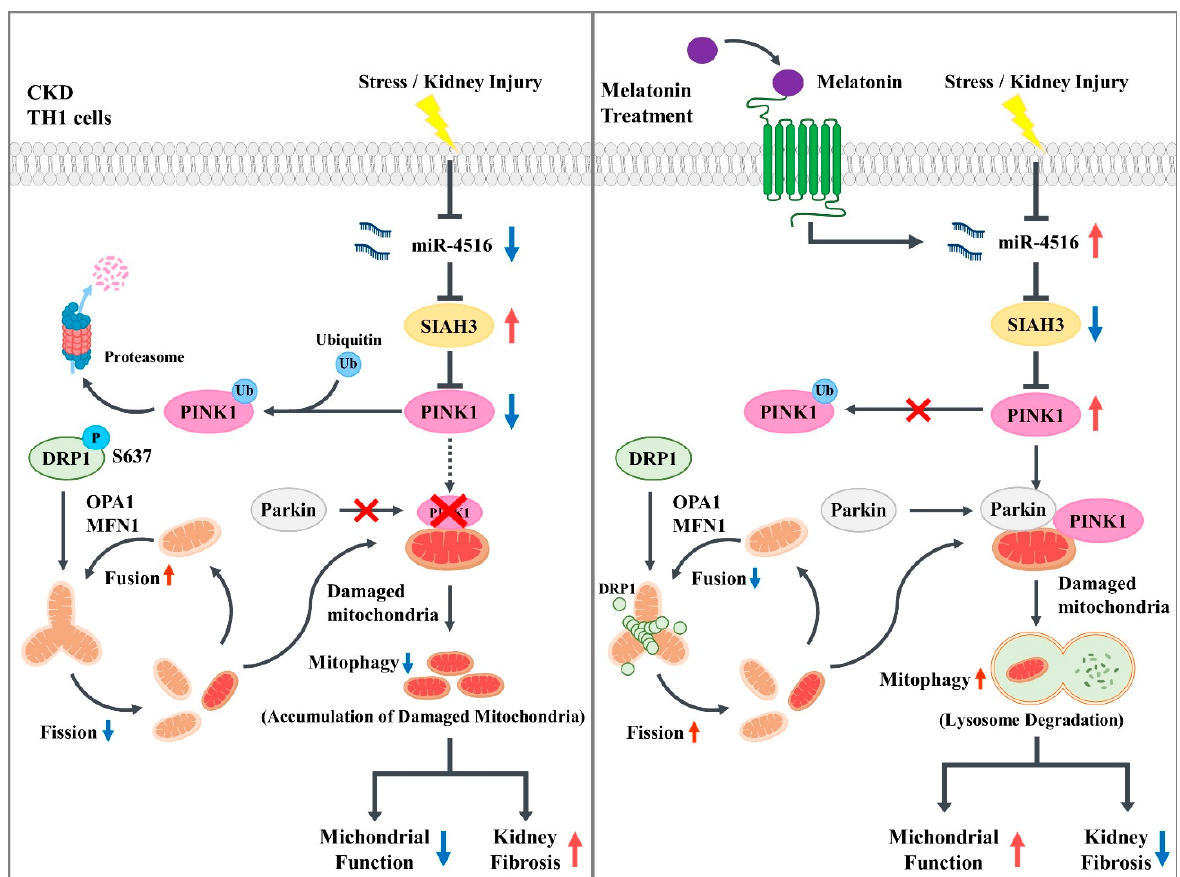
Figure 6. The schematic representation of miR-4516/SIAH3/PINK1 mitophagy pathway in CKD. Schematic representation of the proposed mechanisms by which melatonin-induced miR-4516 inhibits the progression of renal cortical fibrosis via PINK1/Parkin-mediated mitophagy signaling axis. Melatonin-induced miR-4516 suppresses the expression of SIAH3, which is overexpressed in CKD renal cortex, promotes PINK1/Parkin-mediated mitophagy, which reduces dysfunctional mitochondria, and improves kidney function.